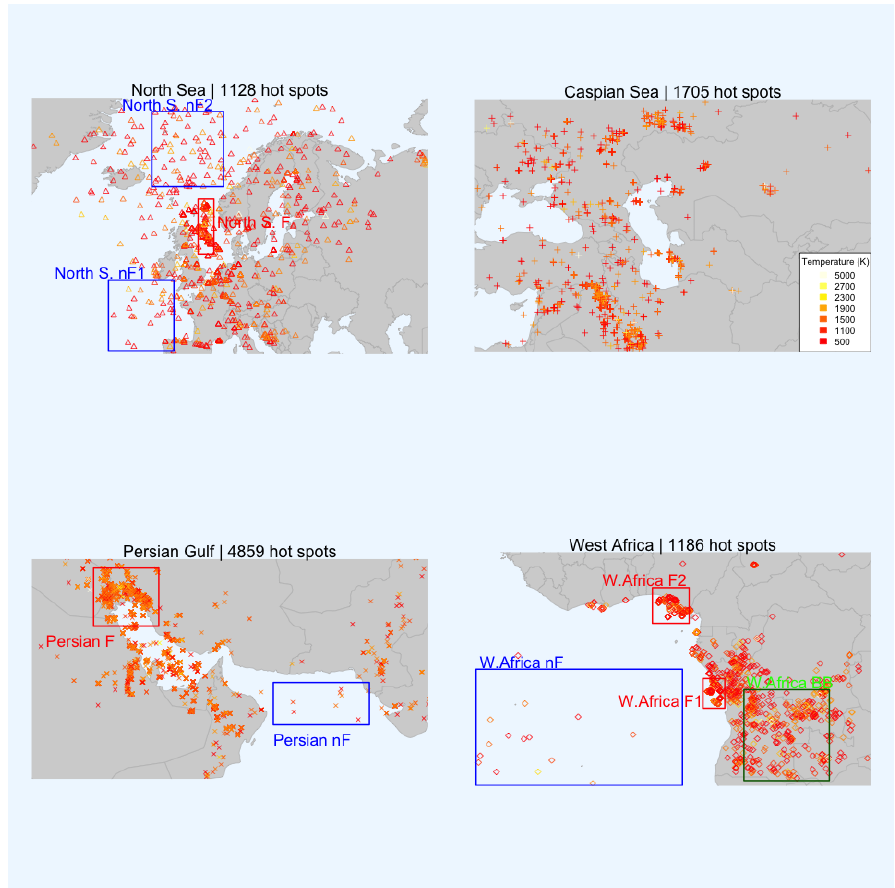
Figure 9. Maps of the hot spots within the test regions. The rectangles represent the 9 study areas (red for flaring, green for biomass burning, blue for non-flaring).